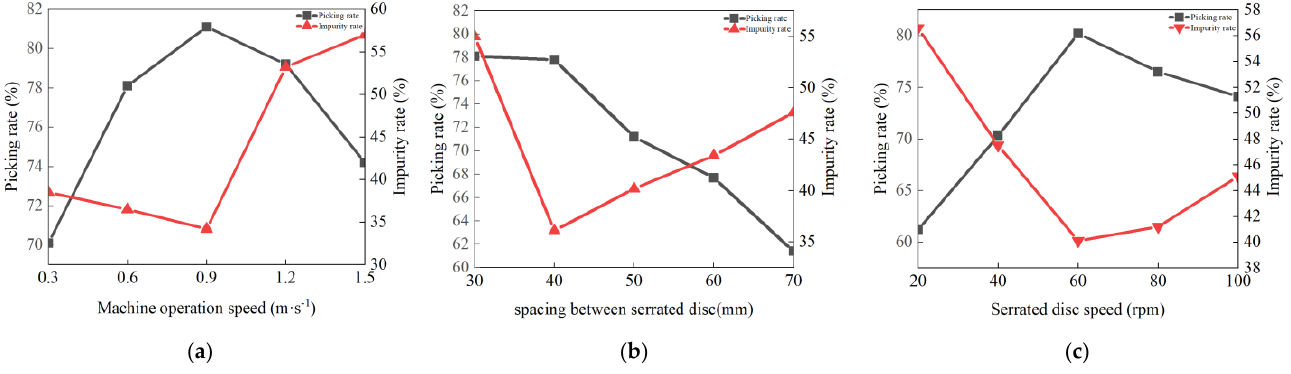
Figure 10. Single factor test. ( a ) The effect of machine operation speed on the operating effect. ( b ) The effect of spacing between serrated discs on the operating effect. ( c ) The effect of the serrated disc speed on the operating effect.